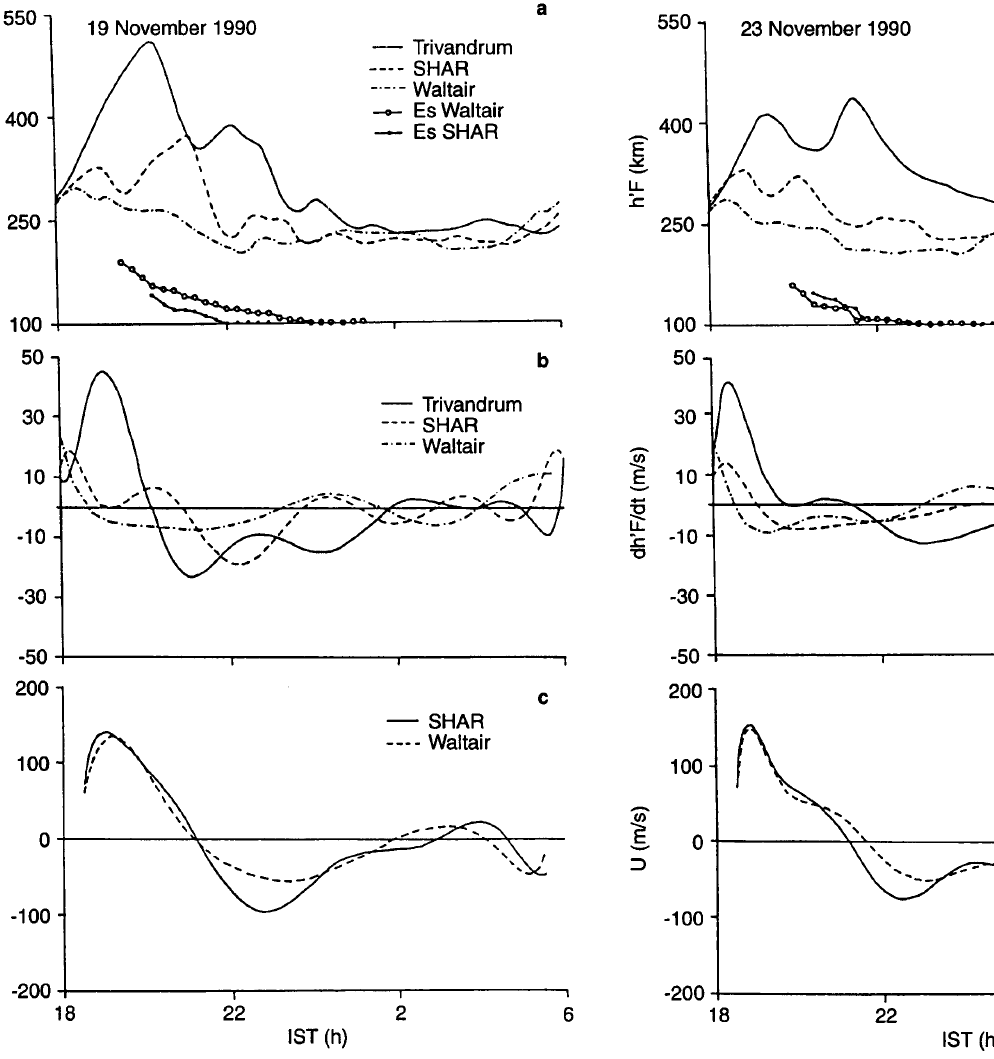
and c U at the three stations z